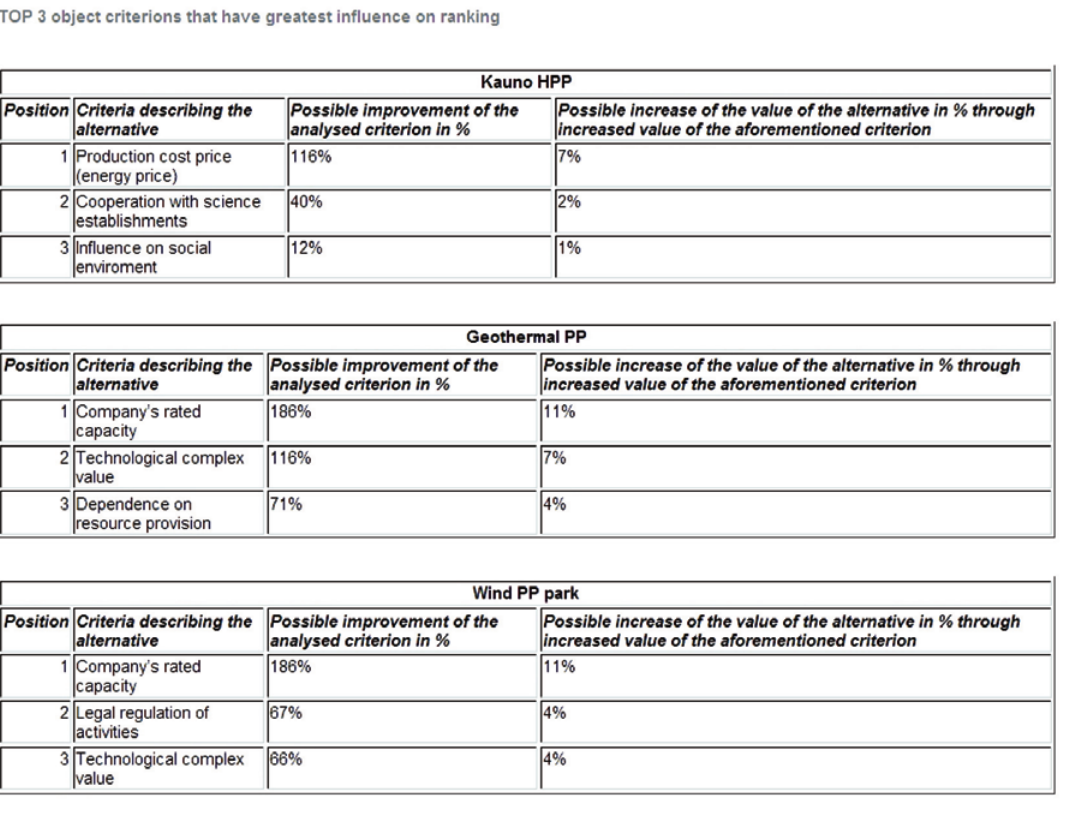
Figure 7. The most significant criteria specified by the recommender